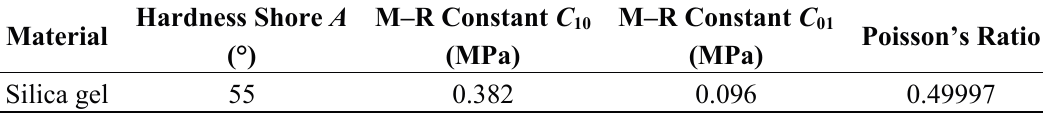
Table 6. Mechanical properties of silica